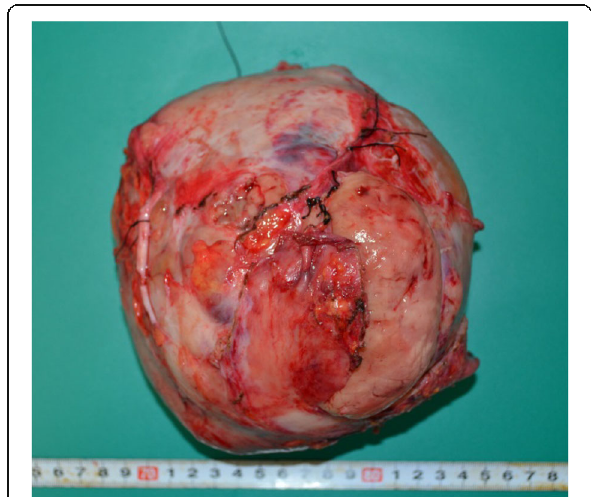
Fig. 5 The specimen of the second surgery. The retroperitoneal tumor looked flat and smooth similar to the intra-abdominal tumor classified into five categories, namely, well-differentiated (45%), differentiated (20%), pleomorphic (10%), round cell (5%), and myxoid type (rare). Most giant liposarco- mas are usually seen as differentiated tumors [4, 5].